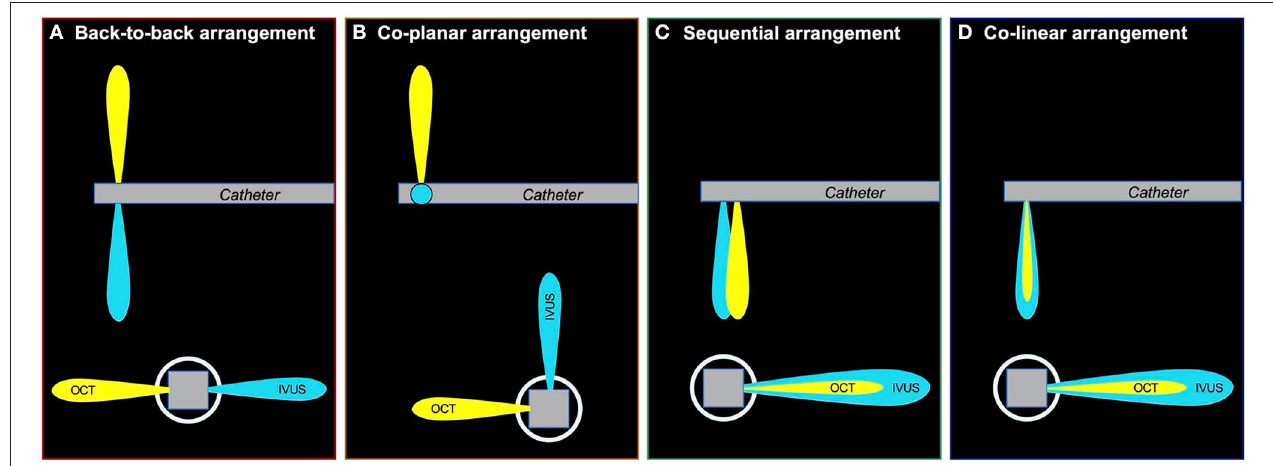
FIGURE 3 | Various types of arrangements of IVUS and OCT transducer. There were three types of arrangements of IVUS and OCT transducer; (A) : back-to-back arrangement; (B) : coplanar arrangement; (C) : sequential arrangement; (D) : colinear arrangement. The colinear arrangement can acquire the strictest coregistration image of IVUS and OCT in three types of arrangements. IVUS, intravascular ultrasound; OCT, optical coherence tomography.